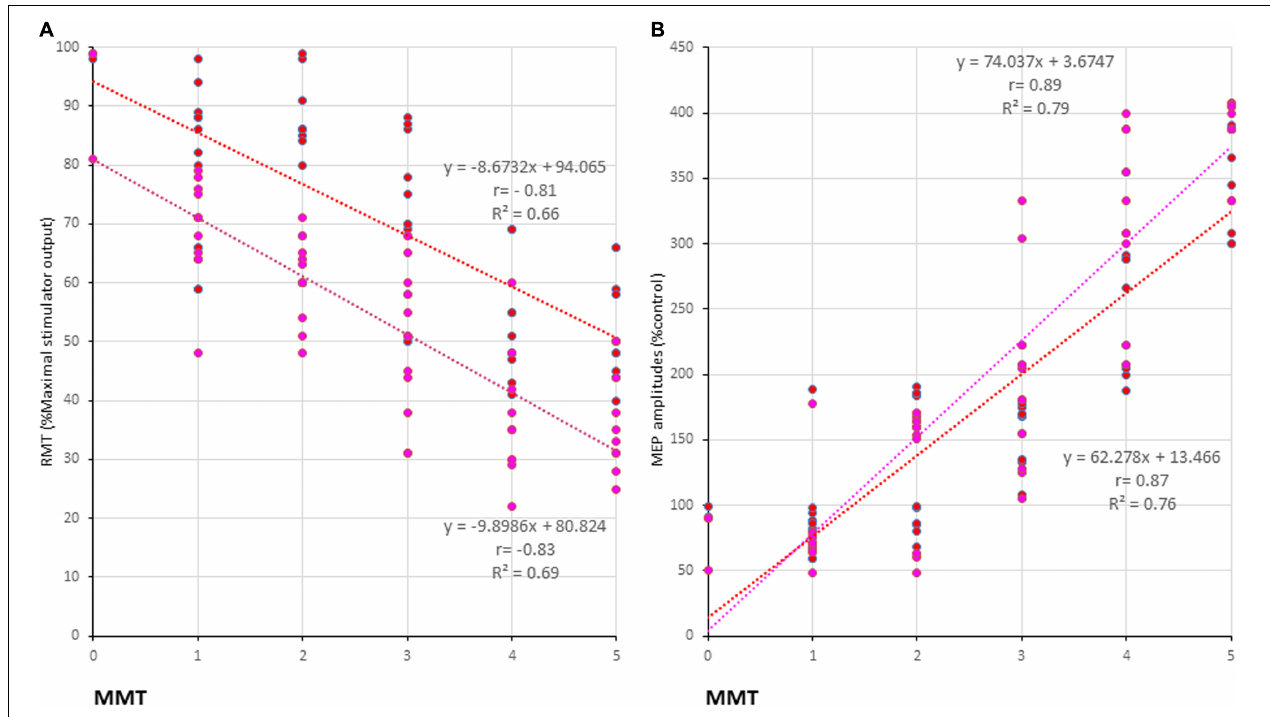
FIGURE 5 | Correlation between manual muscle testing (MMT) grades and physiological parameters of 500-Hz quadripulse theta burst transcranial magnetic stimulation (QTS) motor evoked potential (MEP). There were significant correlations between MMT neurological grades and RMTs (A) , and amplitudes (B) of QTS-PA/AP-MEP ( p < 0.001, respectively). Colors in the graph represent each condition before and after Theta burst stimulation [TBS; red: 500 Hz QTS-AP, pink: 500 Hz QTS-PA in patients with intracerebral hemorrhage (ICH),